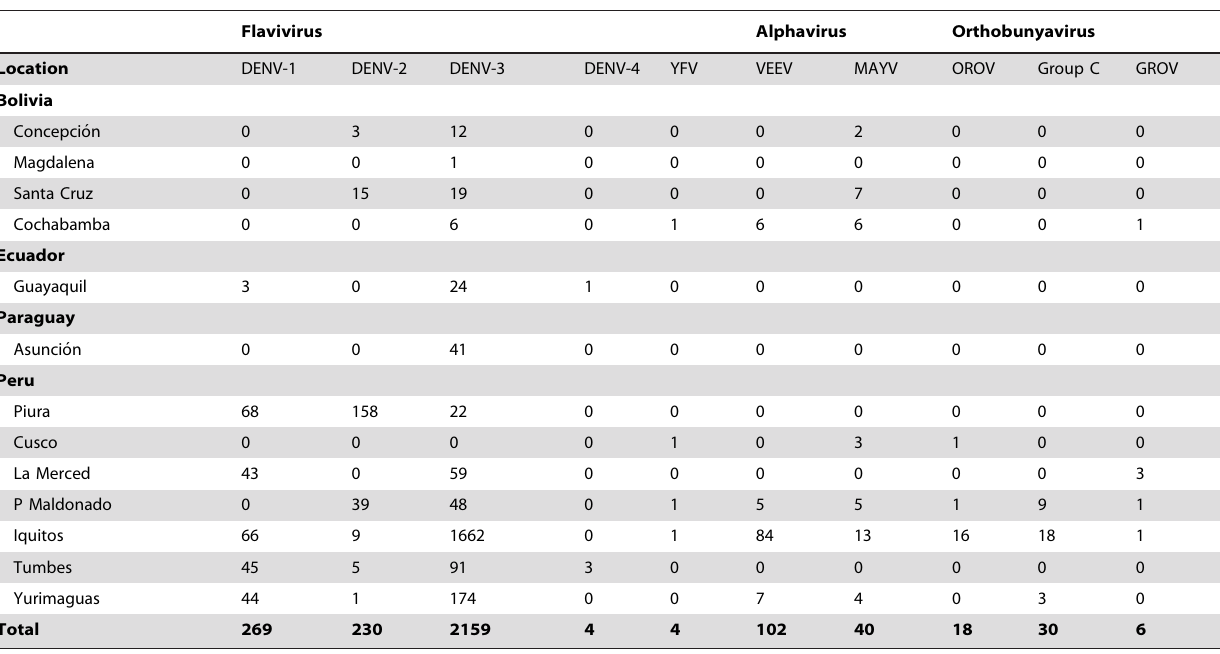
Table 4. Virus isolates, by location, 2000–2007.